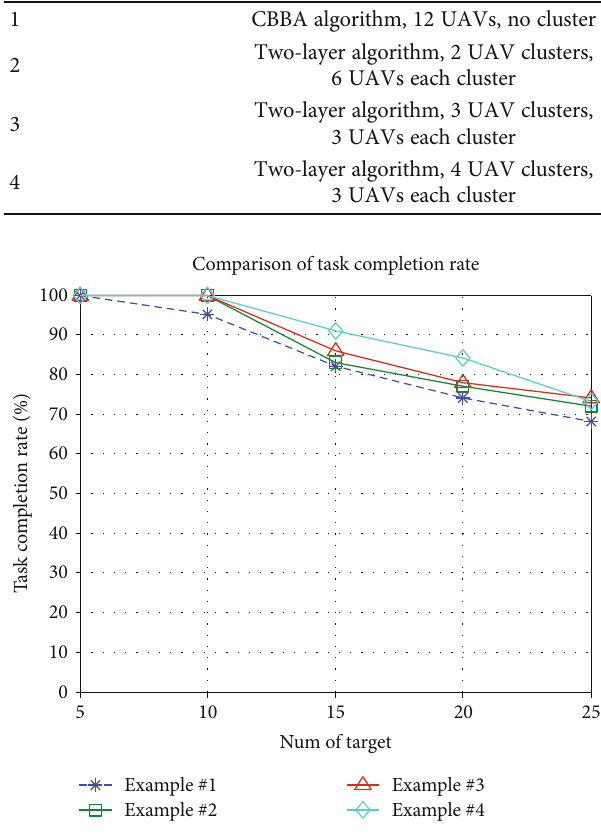
Figure 11: The comparison of total completion rate obtained by two types of